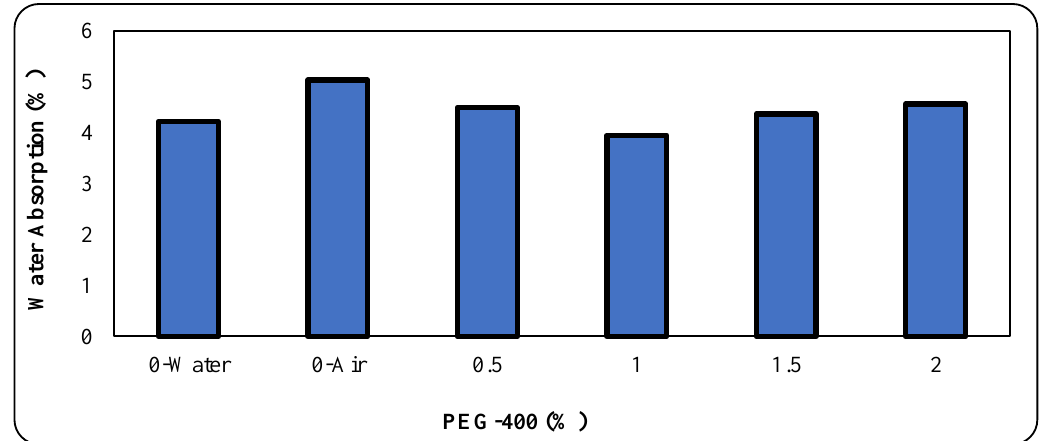
Figure 9. Water absorption of concrete containing different PEG percentages .